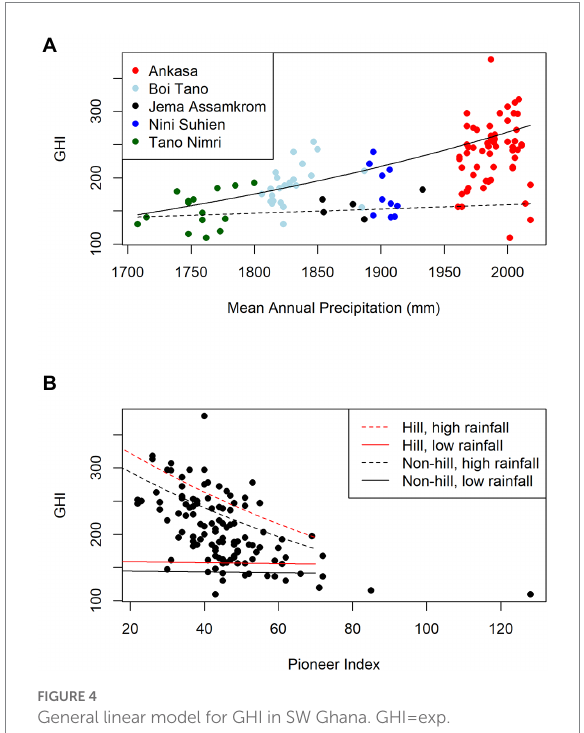
FIGURE 4 General linear model for GHI in SW Ghana. GHI = exp. (0.109 + 0.0523 × PI + 0.00291 × Bio12 + − 0.0000310 × Bio12 × PI ( − 0.0934 for Non-hilltops)). Adj. R 2 = 56%, n = 114, all terms are significant ( p < 0.05). (A) Samples are coloured by Reserve. The dotted line shows model fit with high Pioneer Index (PI; PI = 80), the solid line at low PI (PI = 25), LAND is set to Non-hill. (B) Model fit for high rainfall (Bio12 = 2,018 mm, dotted lines) and low rainfall (Bio12 = 1,708 mm, solid lines); hill top samples are shown in red, non-hilltop samples in